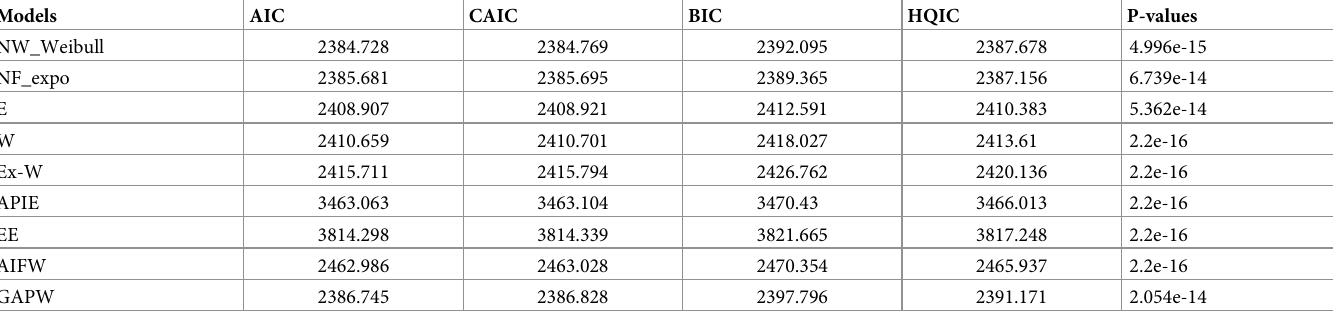
Table 5. Goodness of fit measures for Covid-19 data of